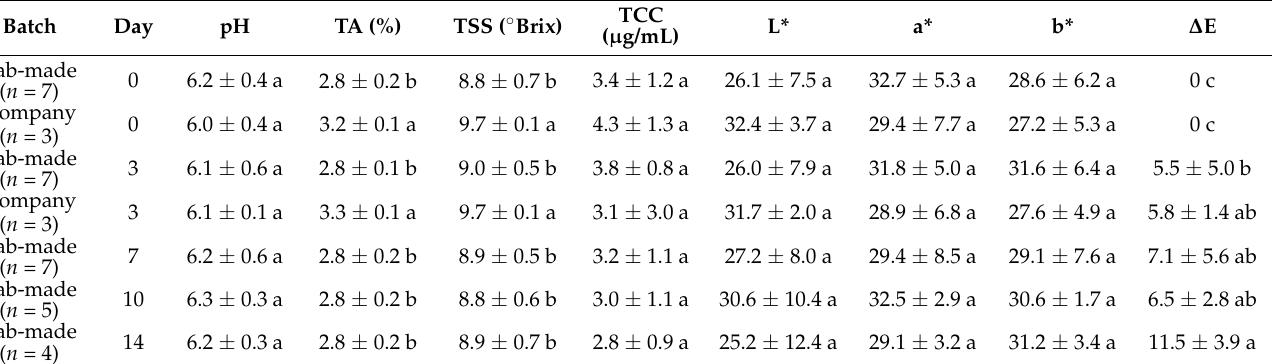
Table 1. pH, titratable acidity (TA), total soluble solids (TSS), total carotenoid content (TCC) and color (L*, a*, b*, and color difference ∆ E to the initial day) of lab-made (batches L1 to L7) and company juices (batches C1 to C3). The letter n indicates the number of analyzed independent batches. Values are the means ± standard deviation of three analytical replicates of the n batches. Different letters in the same column indicate significant differences detected with REGWQ test ( p <